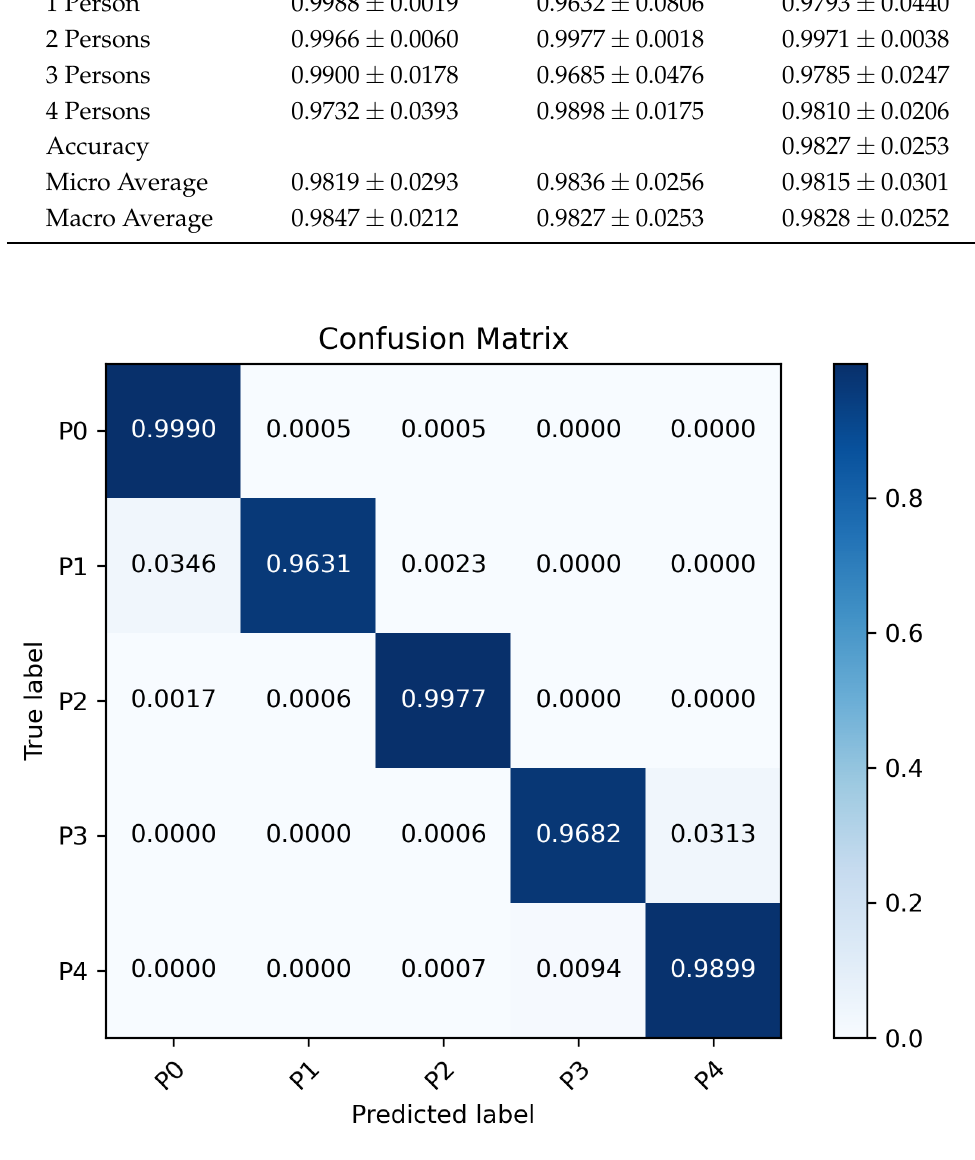
Figure 10. Confusion matrix normalized over the 5-fold cross-validation evaluation